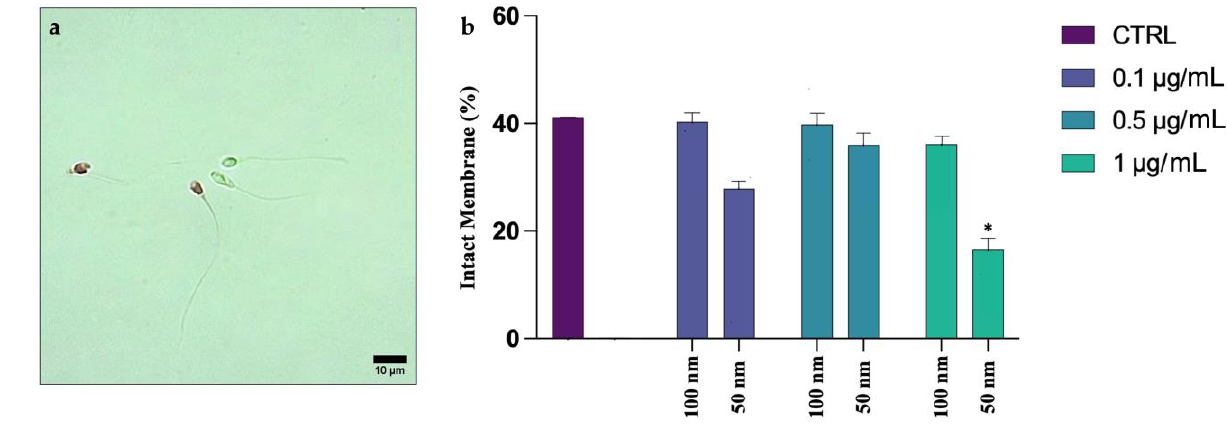
Figure 1. ( a ) Eosin test: spermatozoa with intact membrane (translucid) and spermatozoa degraded membrane (pink); ( b ) mean percentage of spermatozoa with intact membrane after exposure (30 min) to 50 and 100 nm PS-NPs at increasing concentrations. Approximately 400 spermatozoa were counted in five different fields for each sample. In addition, two replicates were performed, in a total of 8 samples and 3200 spermatozoa analyzed. Statistic differences (* p < 0.05) have been observed between group exposed to 1 µg/mL of 50 nm PS-NPs and control (CTRL).